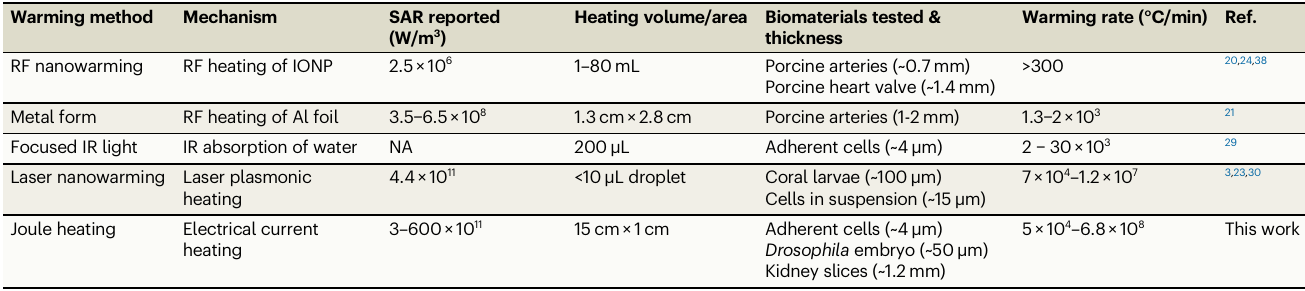
Table 1 | Summary of rewarming methods* Warming